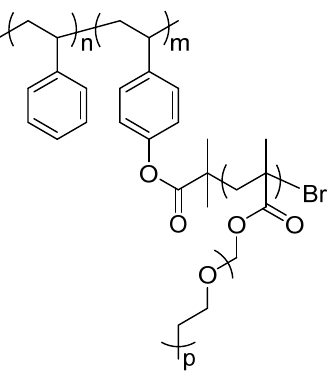
Scheme 1. Structure of the polymers investigated by Solid ‐ state NMR.